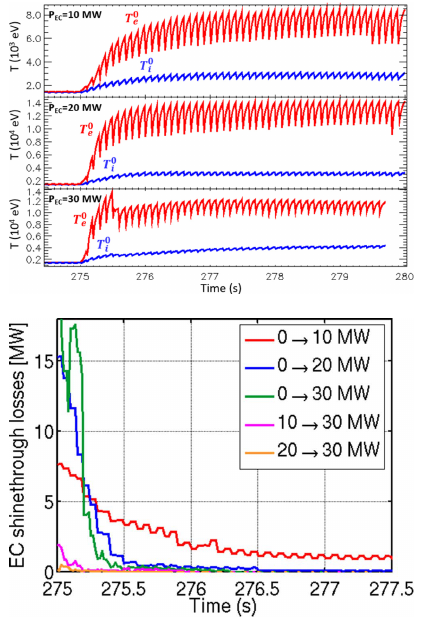
Figure 1. Modeling results for X3 heating in ITER from [3], figs. 6, 9. Top: evolution of central T e , T i after switching on 10 − 30 MW of ECRH. Bottom: evolution of the power not absorbed during the first path through the plasma.